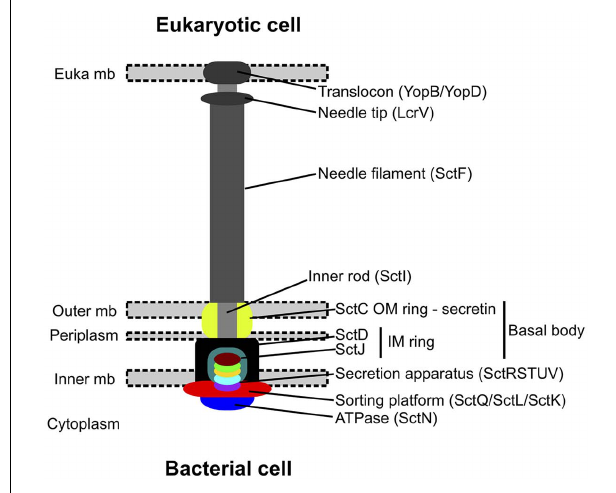
FIGURE 1 |Assembled structure of the type 3 secretion system (modified fromAbby and Rocha, 2012). This system is made of an extracellular part for close contact with host cell, and a membrane-associated part containing the core secretion apparatus.The components with bright colors correspond to the most conserved components, and are thus the one searched by sequence similarity to assess the system’s presence in the assembled